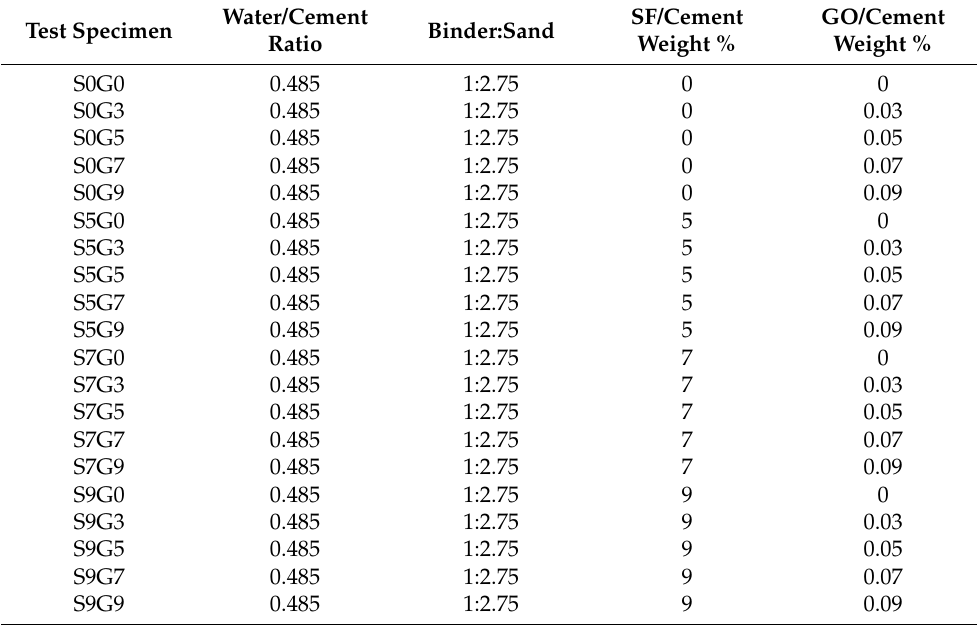
Table 2. Mix proportion of test